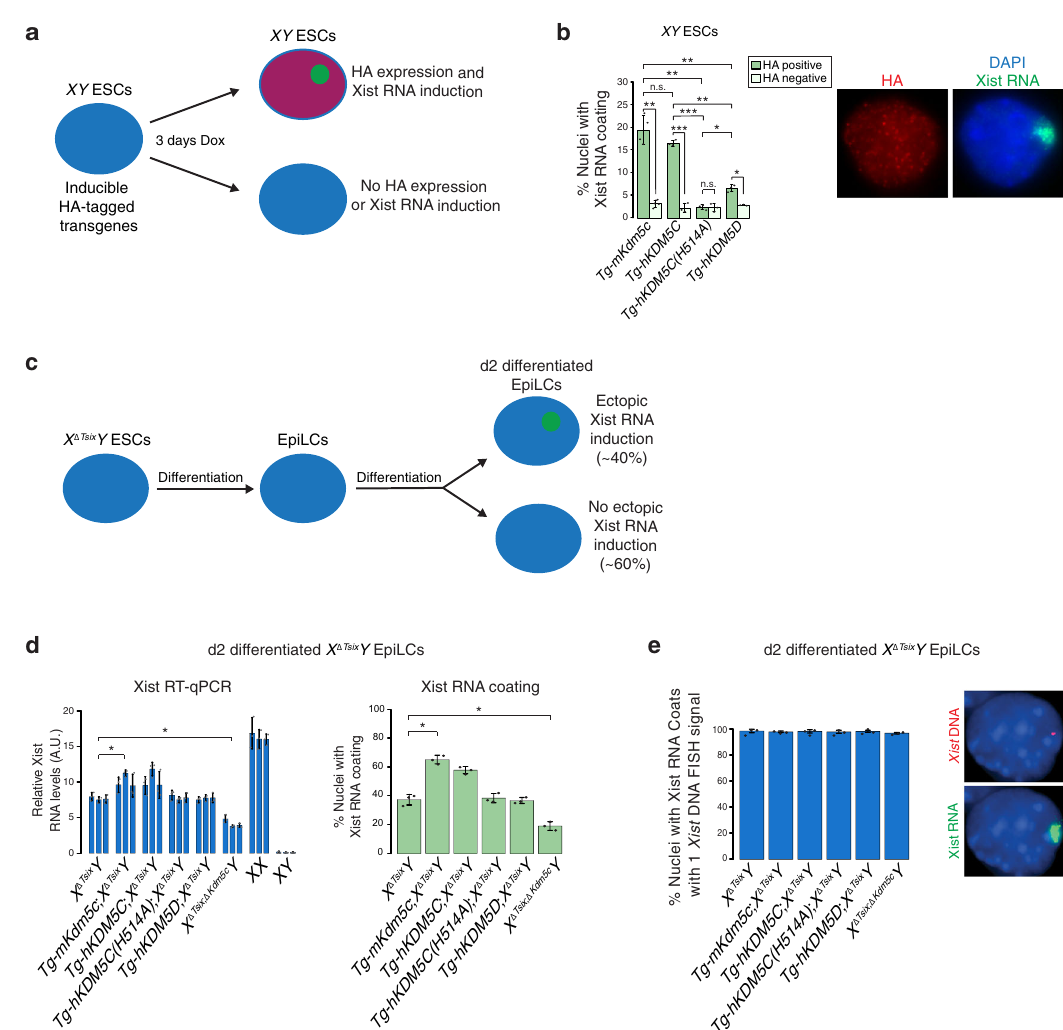
Fig. 4 Ectopic KDM5C expression induces Xist in male ESCs. a Schematic of ectopic expression of HA-tagged transgenes in XY male ESCs. b Quanti fi cation of nuclei with Xist RNA coating in transgenic ( Tg ) XY male ESC lines ( n = 3) expressing HA-tagged mouse KDM5C ( Tg-mKdm5c ; n = 292, 437, and 210); human KDM5C ( Tg-hKDM5C ; n = 154, 212, and 184); enzymatically inactive KDM5C ( Tg-hKDM5C(H514A) ; 45 n = 292, 295, and 316); and, KDM5D ( Tg-hKDM5D ; n = 262, 222, and 232) proteins. Representative nuclei with IF detection of the HA epitope tag (red) coupled with FISH detection of Xist RNA (green) in the XY male ESCs. Data are presented as mean ± SEM. P values, Welch ’ s two-sided t test. n.s., not signi fi cant; * P ≤ 0.05; ** P < 0.01; *** P < 0.001. See Supplementary Table 5 for all pairwise statistical comparisons. c Schematic of ectopic Xist RNA induction in day (d) 2 differentiated X Δ Tsix Y male ESCs. See also Supplementary Fig. 2c, d. d Quanti fi cation of ectopic Xist RNA expression by RT-qPCR (left) and Xist RNA-coated nuclei by RNA FISH (right) in d2 differentiated X Δ Tsix Y EpiLCs ectopically expressing mouse KDM5C ( Tg-mKdm5c ; X Δ Tsix Y ); human KDM5C ( Tg-hKDM5C ; X Δ Tsix Y ); enzymatically inactive KDM5C ( Tg-hKDM5C(H514A) ; X Δ Tsix Y ); KDM5D ( Tg-hKDM5D ; X Δ Tsix Y ); and, X Δ Tsix Y EpiLCs lacking KDM5C ( X Δ Tsix ; Δ Kdm5c Y ). For both the Xist RNA FISH and the Xist RT-qPCR data, three independent ESC lines/genotype were differentiated into d2 differentiated EpiLCs/genotype. For Xist RNA coating analysis, n = 100 nuclei per sample. Data are presented as mean ± SEM. For RT-qPCR, each sample was analyzed in triplicate. Data are presented as mean ± standard deviation between technical replicates. P values, Welch ’ s two-sided t test on Δ Ct values of biological replicates. * P ≤ 0.05; ** P < 0.01; *** P < 0.001. See Supplementary Table 6 for all pairwise statistical comparisons. e DNA FISH following RNA FISH demonstrates the presence of one X chromosome in nuclei with ectopic Xist RNA coating in the differentiated EpiLCs. n = 100 nuclei from three independent ESC lines differentiated into EpiLCs/genotype. Data are presented as mean ± SEM. See also Supplementary Fig. 3. Source data are provided as a Source Data fi